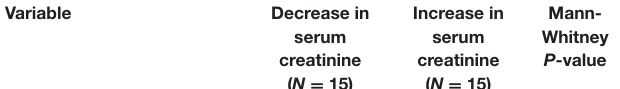
TABLE 2 | Urine analyses of kidney injury biomarkers before surgery and on the first morning after the surgery.